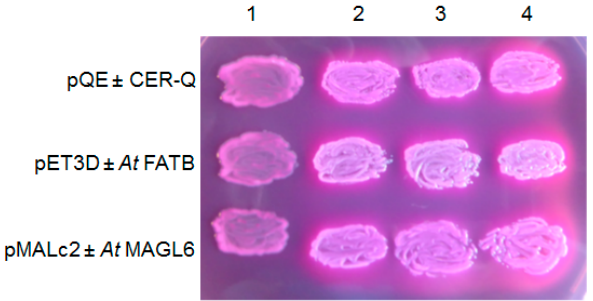
Figure 5. Hv CER-Q as the At FATB thioesterase, and At MAGL6 lipase expressed in Escherichia coli K27 ( fadD88 ) on MacConkey plates excrete free acids into the medium that the pQE80, pET3D and pMAL-c2 vectors, respectively, do not. Lane 1, empty vectors; lanes 2, 3 and 4, vector plus designated insert in three independent transformants. Plates contained 0.5% lactose, 100 μ g. mL − 1 ampicillin, and 0.3 mM IPTG and was placed at 30 °C for 20 h.